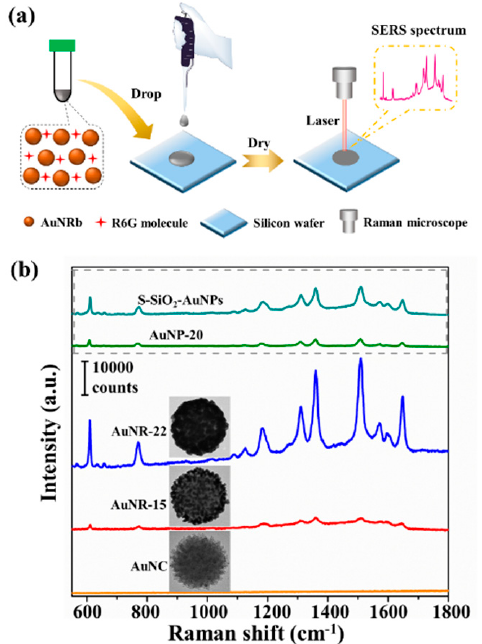
Figure 5. ( a ) A schematic diagram of surface enhanced Raman scattering (SERS) detection. ( b ) The SERS performance of AuNC, AuNRb-15, AuNRb-22 and AuNP-20 using Rhodamine 6G (R6G) as the probe molecules with a concentration of 10 − 5 M excited by a 633 nm laser.